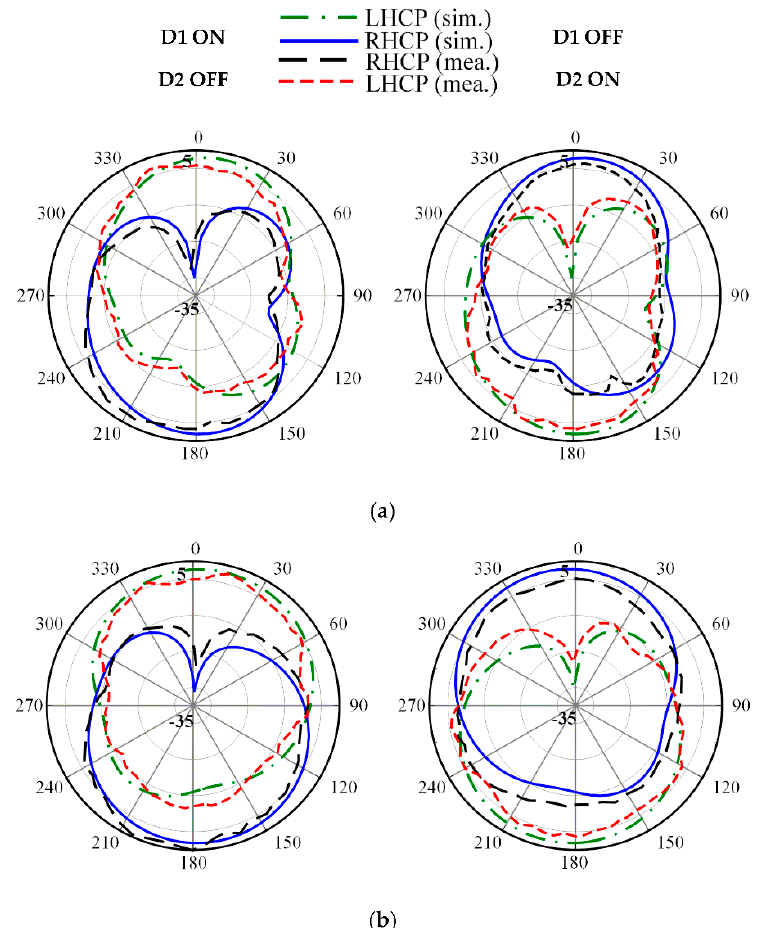
Figure 13. Measured radiation patterns at 3.3 GHz on: ( a ) x - z plane; ( b ) y - z plane. Table 3. Performance comparison with other bi-directional multi-band reconfigurable CP antennas.